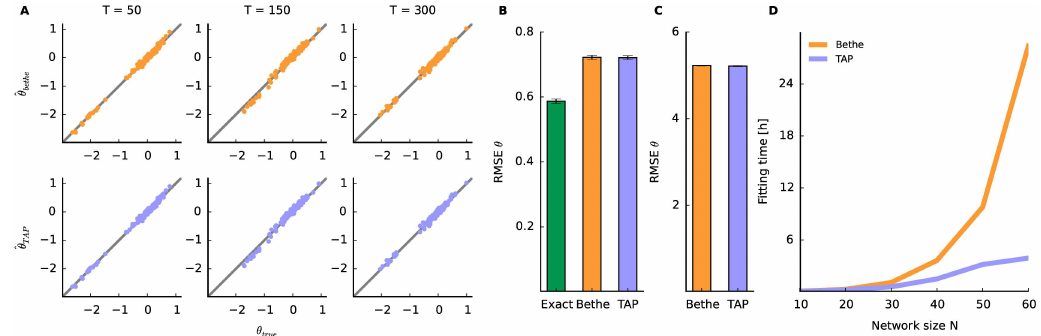
Fig 3. Comparison of the Bethe and TAP approximation. Simulated neuralactivity composed of 500 time bins, and 1000 trials are used to compare the two approximation methods. The underlyingmodel parameters follow Fig 1. A Top: Ground truth θ t of a network of 15 neuronsvs. its smoothedestimate by pseudolikelihood-Bethe approximation at three different time points ( t = 50, 150, 300). Bottom: The same as above obtainedwith pseudolikelihood-TAP approximation. B The RMSE betweenthe true model parameter θ t and its smoothedestimate by the exact inference, pseudolikelihood- Bethe, or pseudolikelihood-TAP approximation. The bar height and error bars indicate the mean and standarddeviation from 10 realizations of data, each sampledfrom the same underlying parameters (generated as in Fig 1). C As in B the RMSE of the estimated model parameters for a network of 60 neurons, composed of 6 equallysized subnetworks. D Runningtime as function of network size for the two different approximation